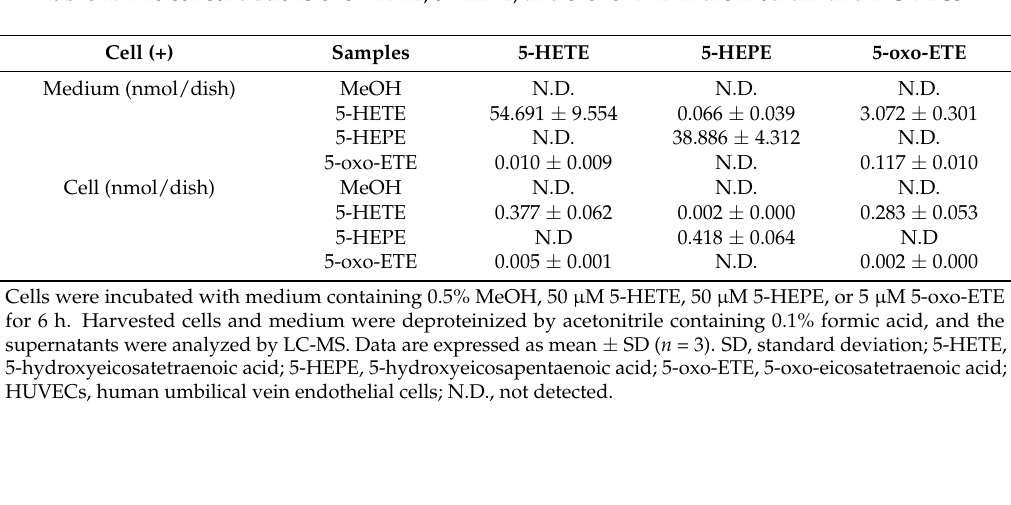
Table 1. The concentrations of 5 ‐ HETE, 5 ‐ HEPE, and 5 ‐ oxo ‐ ETE in the medium and HUVECs.